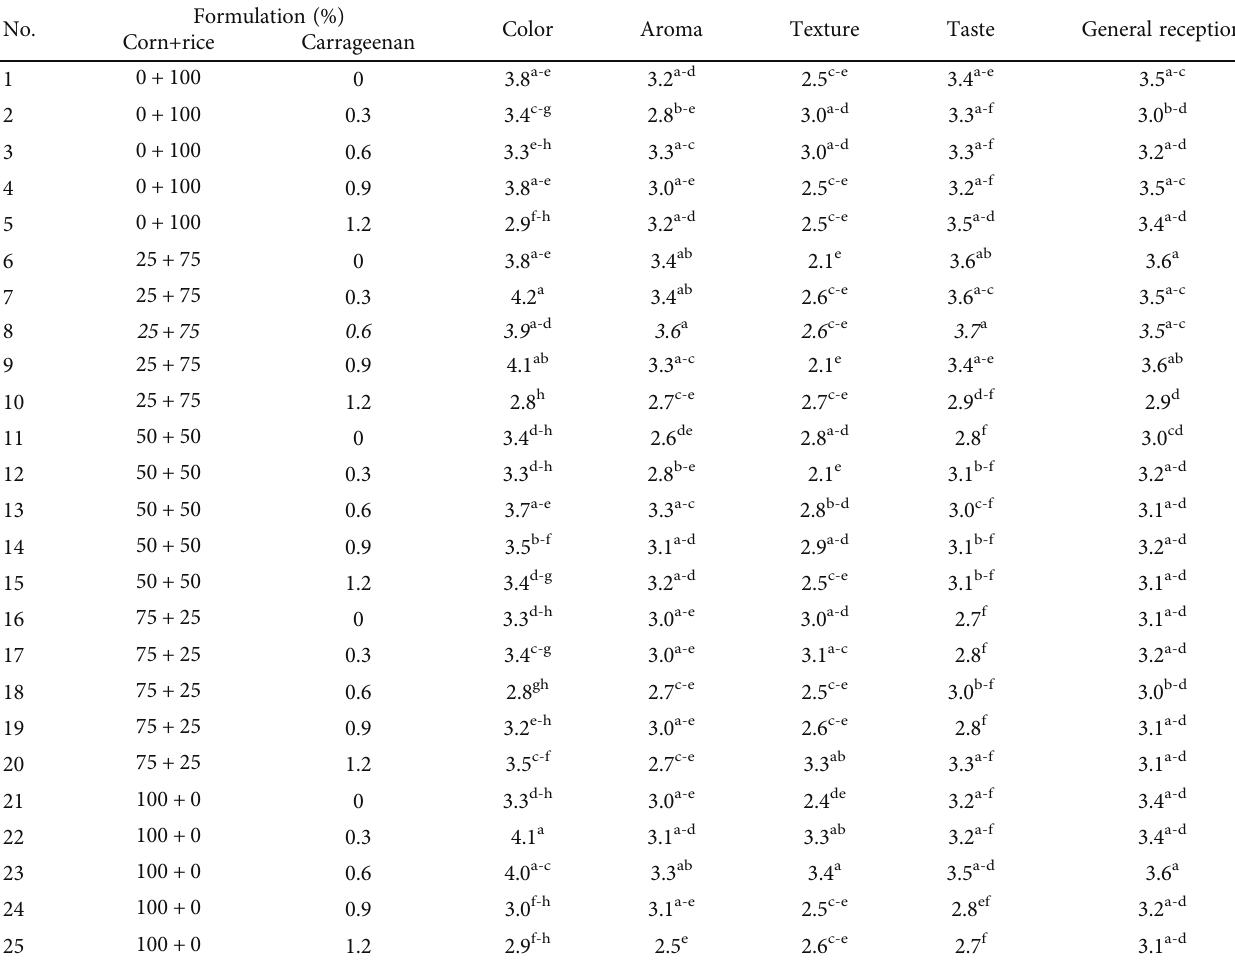
Table 3: Results of organoleptic test of corn and rice mixture vermicelli.